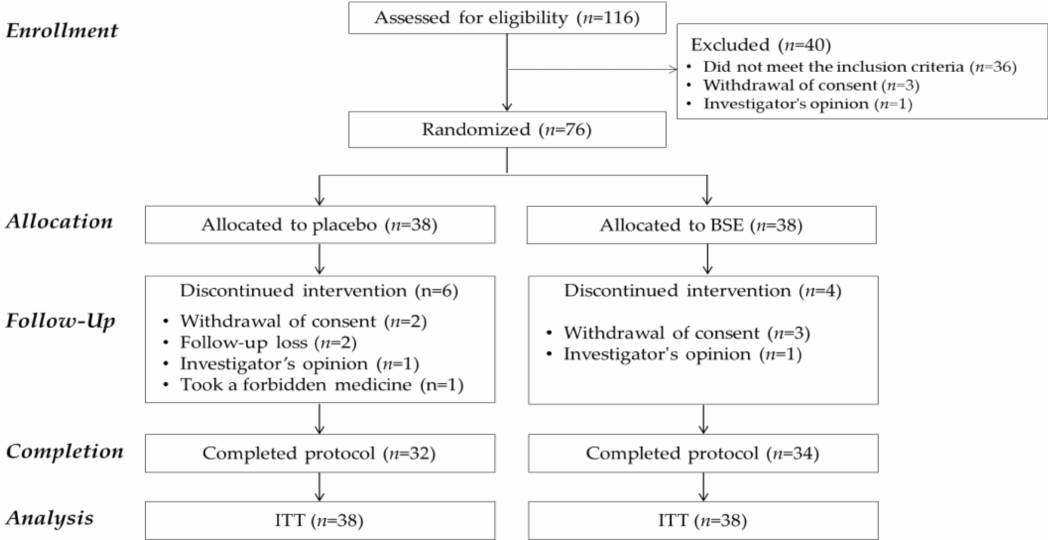
Figure 2. Consolidated standards of reporting trials (CONSORT) diagram of the study. BSE, barley sprouts extract powder; ITT, intention-to-treat.